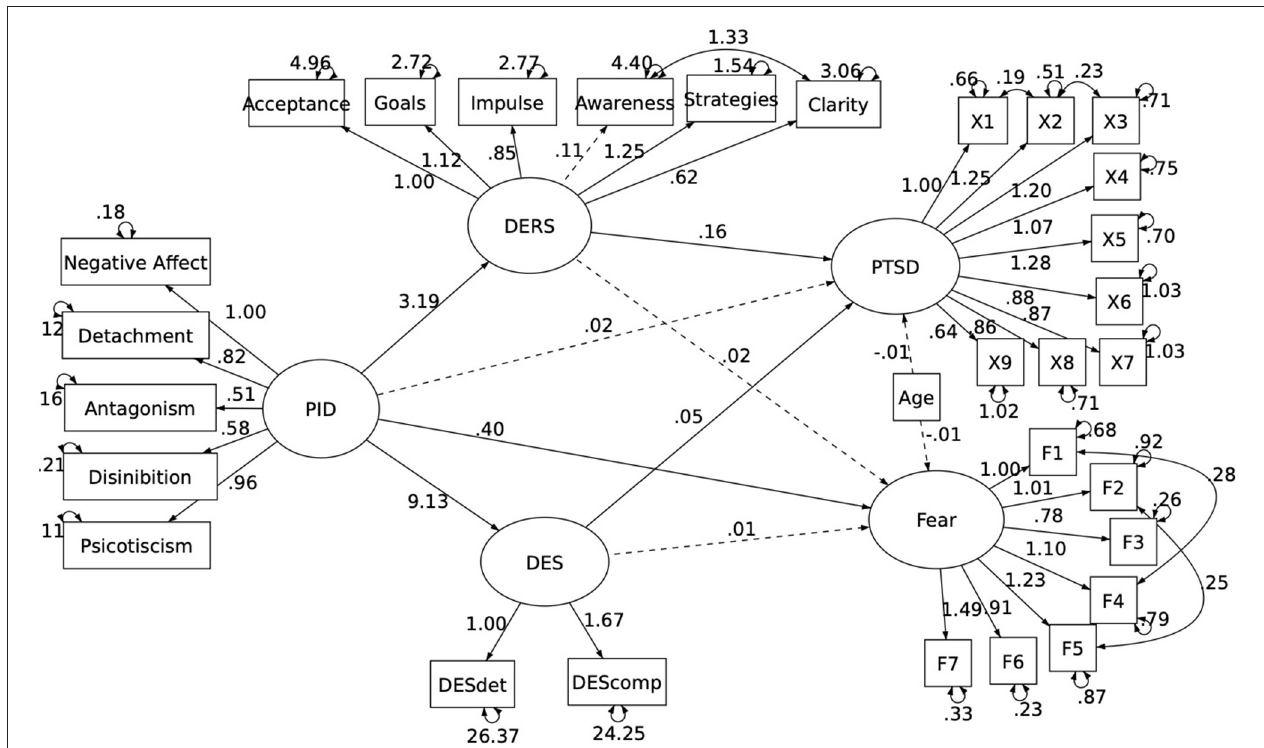
FIGURE 1 | Final Model illustrating the longitudinal relationship between pathological personality and both PTSD and Fear of